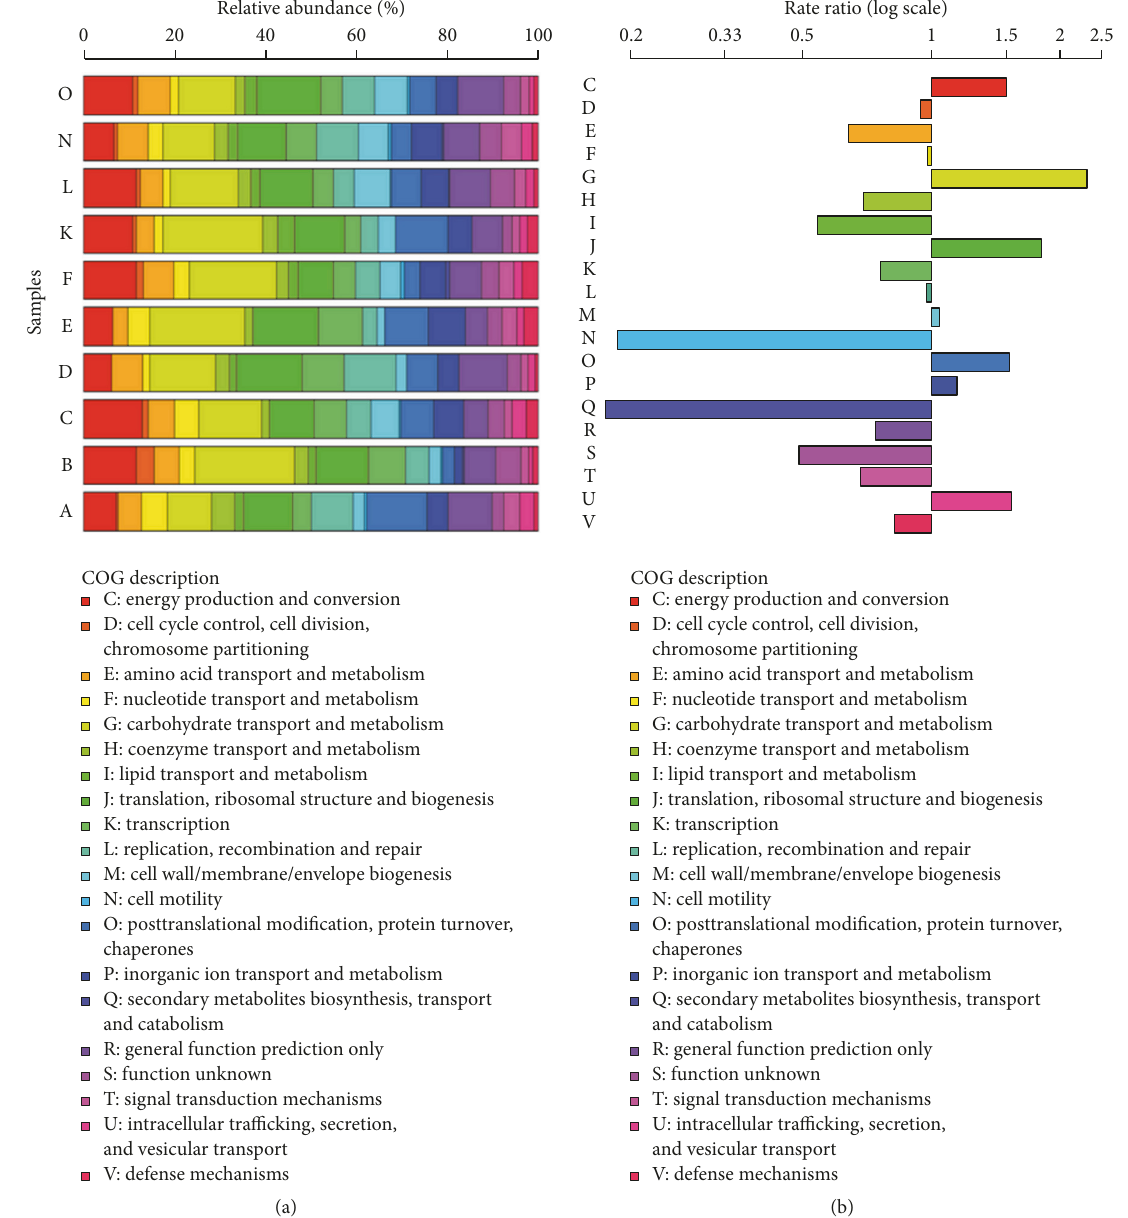
Figure 2: The relative abundance (%) of bacterial processes in the IM of 10 healthy adults (labelled A–O, Panel A, 𝑦 -axis). Sequence data from 10 individuals was searched against a database (gCOGdb) of completely sequenced bacterial genomes ( 𝑛 = 1,012; National Center for Biotechnology Information, 2009) and assigned to Clusters of Orthologous Groups (COG) categories, which indicate likely protein function. Data suggest that carbohydrate and lipid metabolism, energy production, and synthesis of cellular components are the main functions of gut microbiota in these individuals. The rate ratio value (Panel B) was calculated to measure whether COG patterns observed in the 10 individuals were likely due to biases in the existing reference database (gCOGdb). Rate ratios ̸= 1.0 indicate that some categories are over- or underrepresented in the sample of 10 individuals compared to the gCOGdb; these processes likely represent real differences in processes among the 10 individual IM evaluated, above and beyond artifact that might be present in the distribution of COG categories in the general gCOGdb. Reprinted from Gosalbes et al.